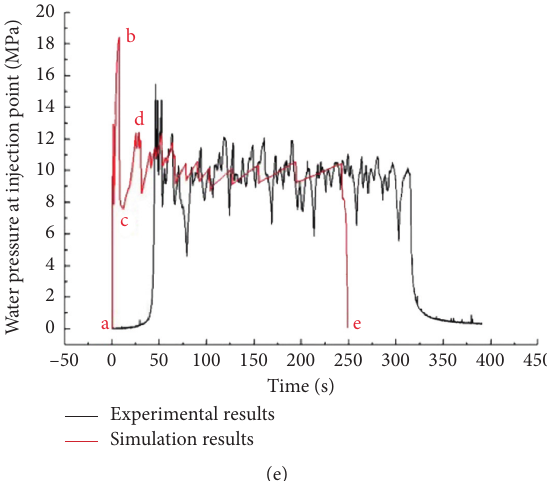
Figure 9: Results of experiments and simulation. (a) Specimen [21]. (b) Simulation results of HF opening displacement (left, unit: m) and fracture pattern of 3# specimen (right, [21]) (stress state: σ v , σ H , σ h � 6, 5, 3 MPa. (c) Water pressure-time curves at injection point obtained from results of simulation and experiments (3# specimen). (d) Simulation results of HF opening displacement (left, unit: m) and fracture pattern of 5# specimen (right, [21]) (Stress state: σ v , σ H , σ h � 9, 5, 3MPa). (e) Pressure-time curves at water injection point obtained from numerical simulation and HF experiments (1#